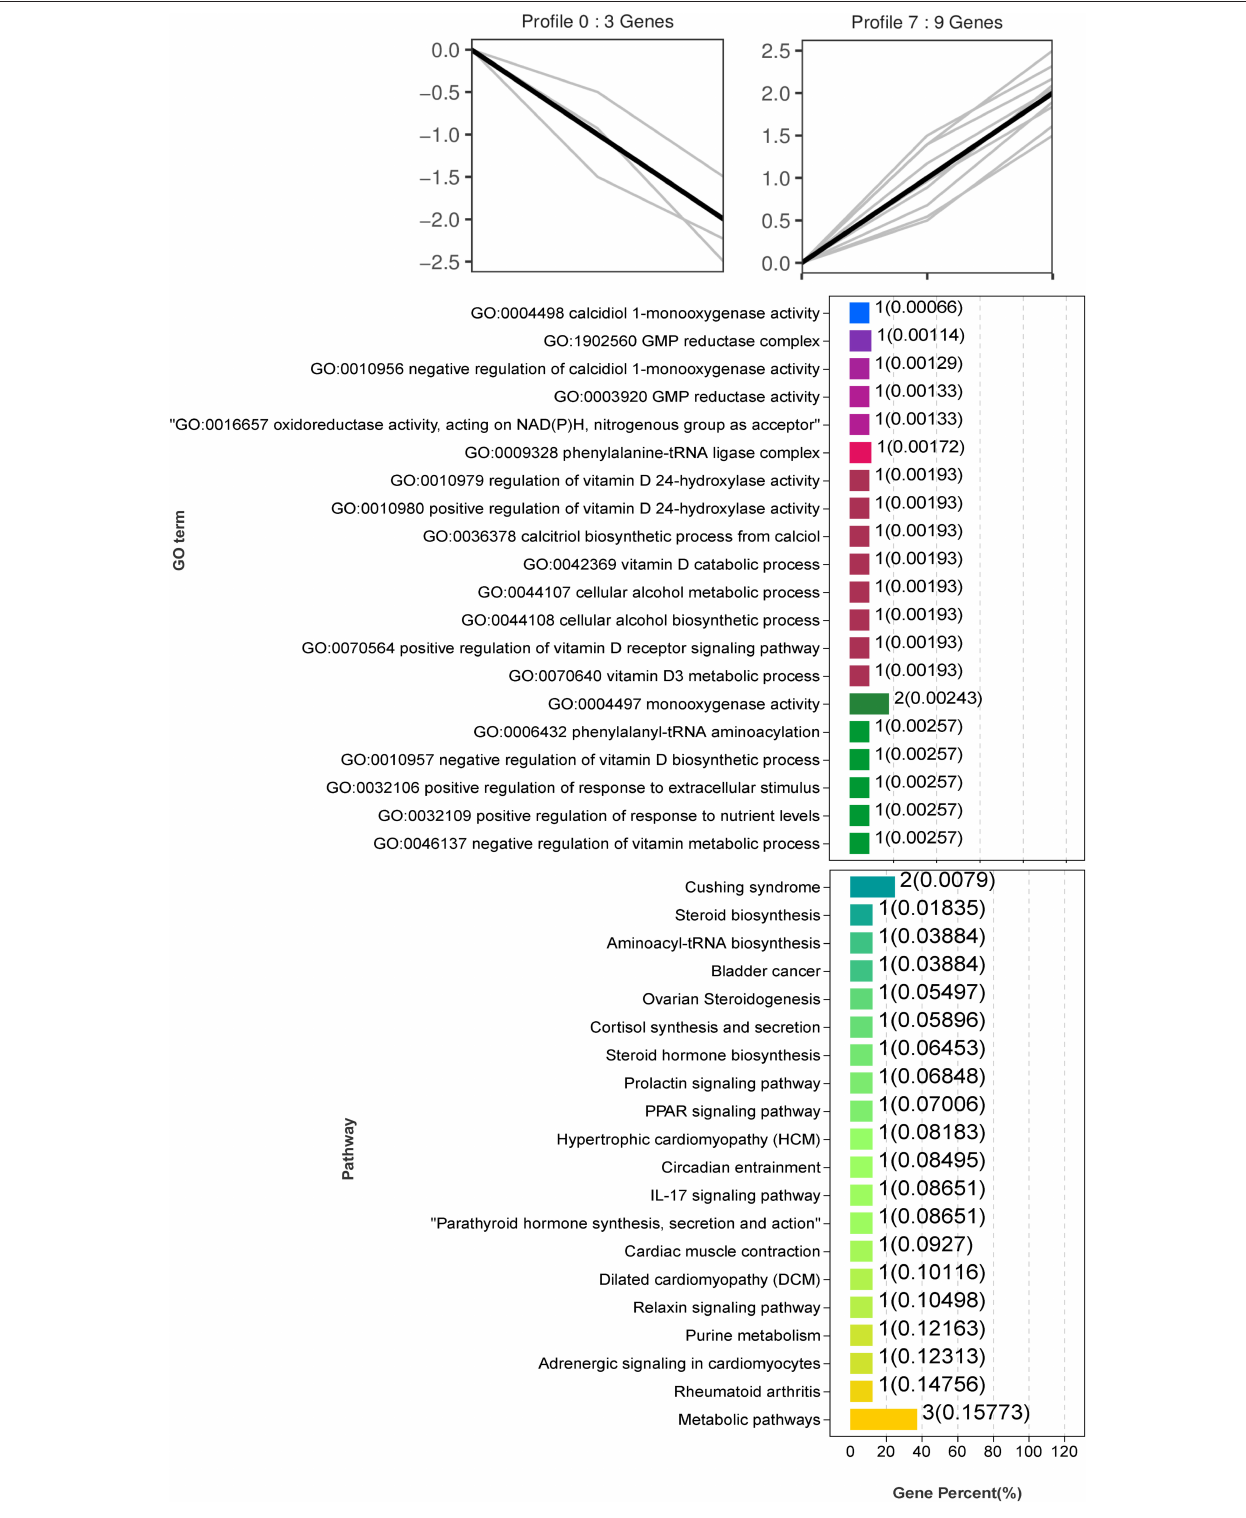
Frontiers in Veterinary Science |